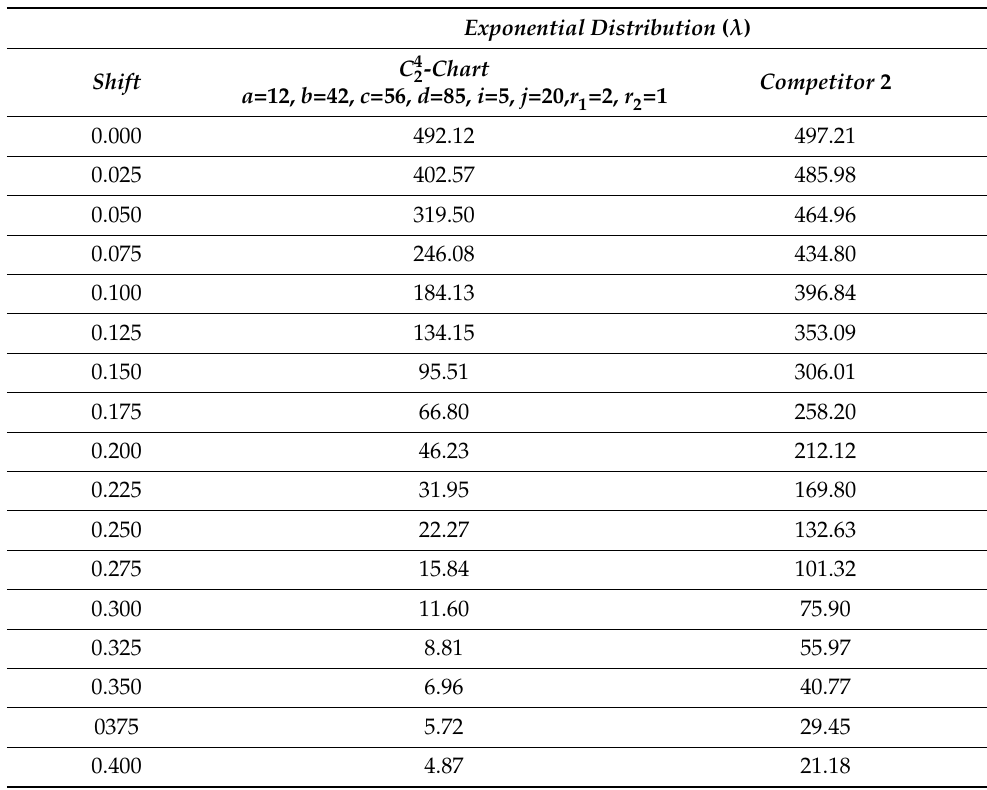
− control charts against competitive schemes under Exponential Table 6. ARL values of the C 4 2 distribution and several shifts ( m = 100, n =